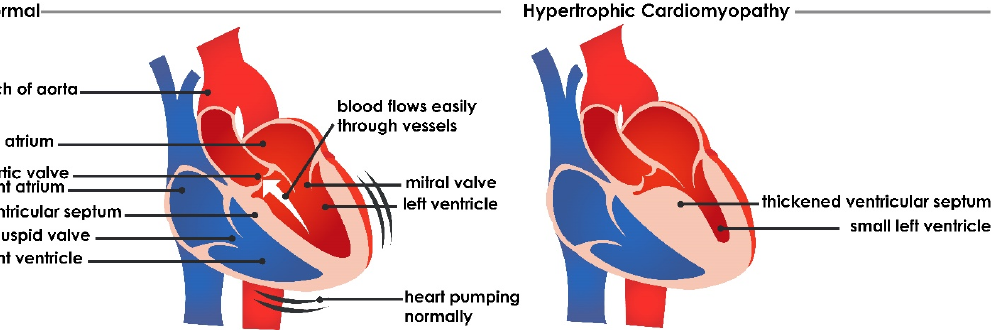
Figure 1. Coronal sections of the heart depicting morphological differences in normal versus hyper- trophic cardiomyopathy. On the cardiac ultrasound (US), the classical form of HCM is typified by asymmet- rical septal hypertrophy, which is defined as an interventricular septal (IVS) thickness of at least 15 mm and increased ratio of the IVS to left ventricular posterior wall thicknesses > 1.3 in the absence of any valve or systemic disease [9]. In other forms, hypertrophy may involve different myocardial segments. HCM can be classified into reverse curvature sep- tum, sigmoid septum, neutral, apical HCM, and midventricular hypertrophy subtypes [10]. Pathophysiologically, this results in both systolic and diastolic left ventricular dys- function [11]. This study aimed to develop an automated detection method to discriminate HCM versus healthy controls on the cardiac US.